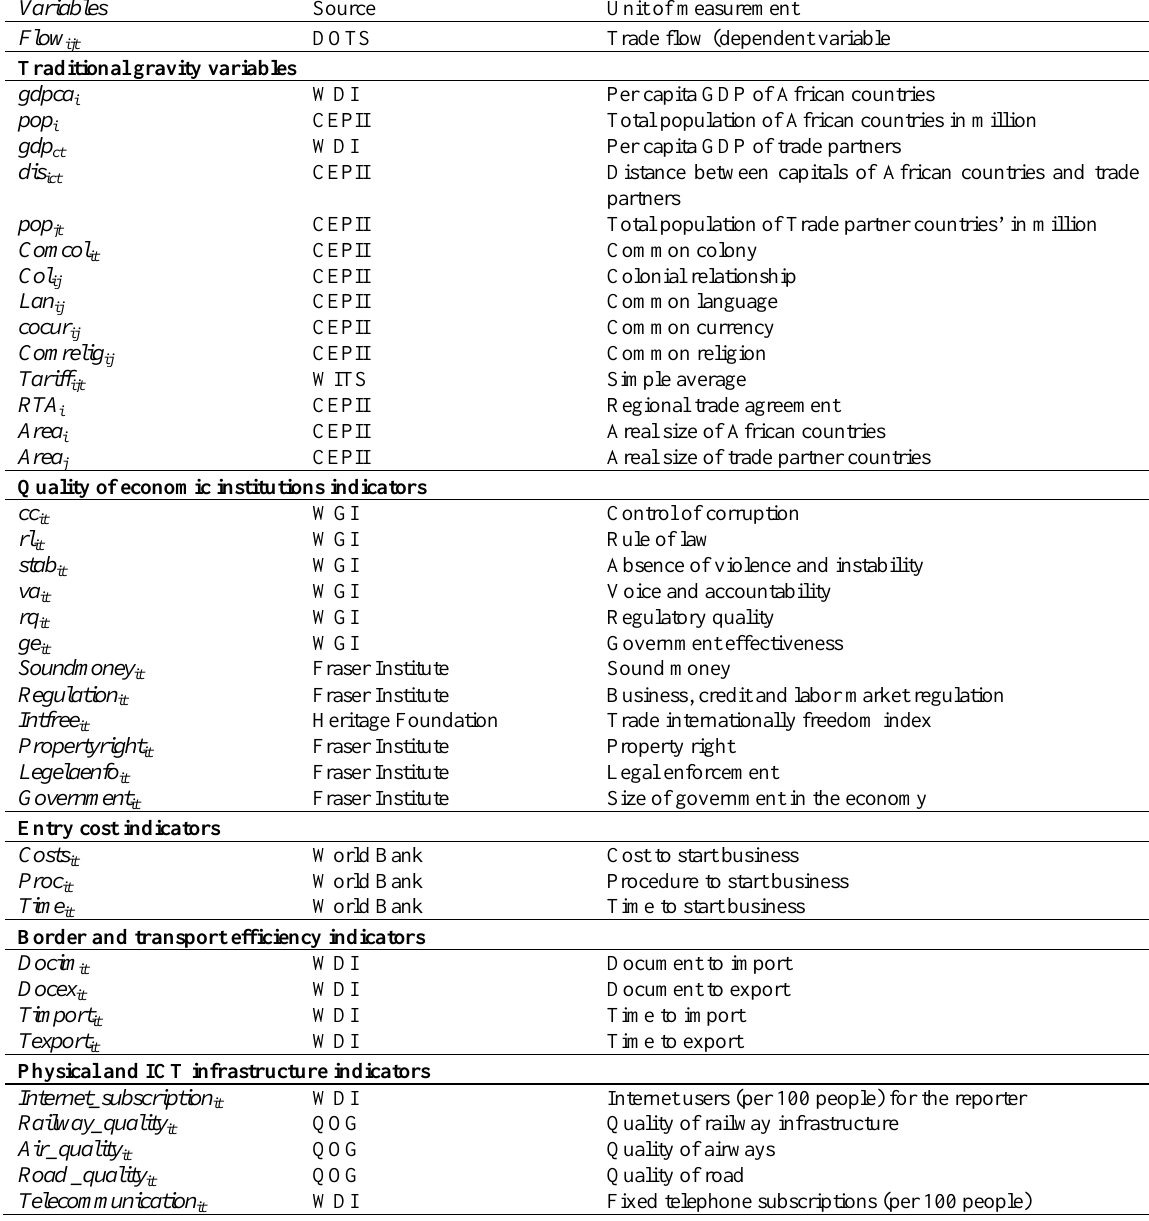
Table 6 : Source and definition of some important